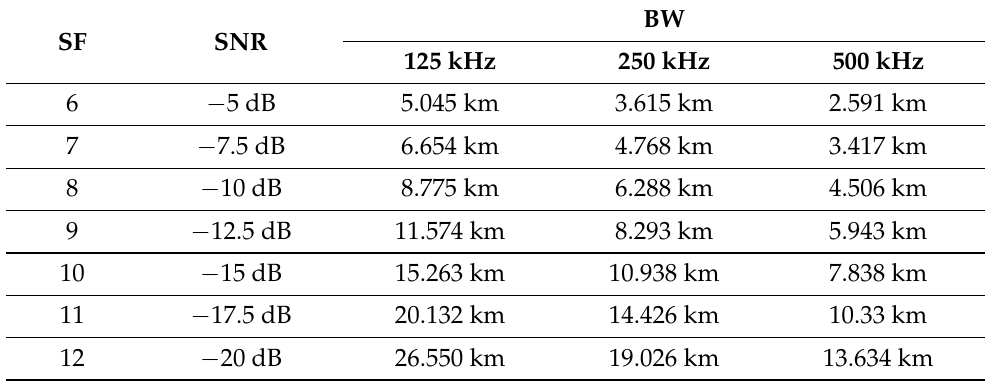
Table 1. Measured distance between a GW and an ED for different SF, SNR, and BW.